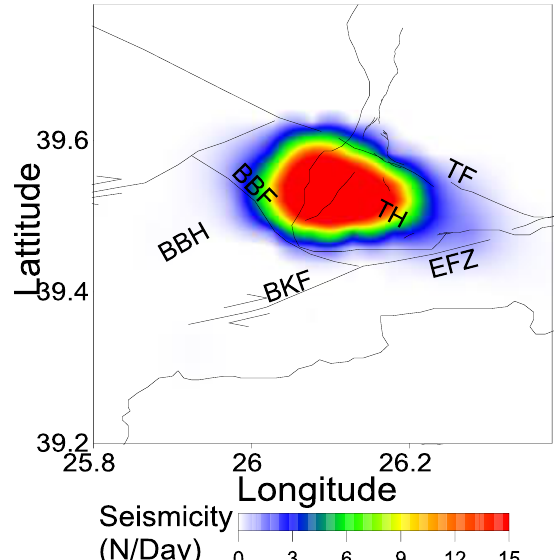
Figure 6. The seismicity in a day between February 06, 2017 and February 28, 2017 in the studying region. N denotes the number of earthquakes.